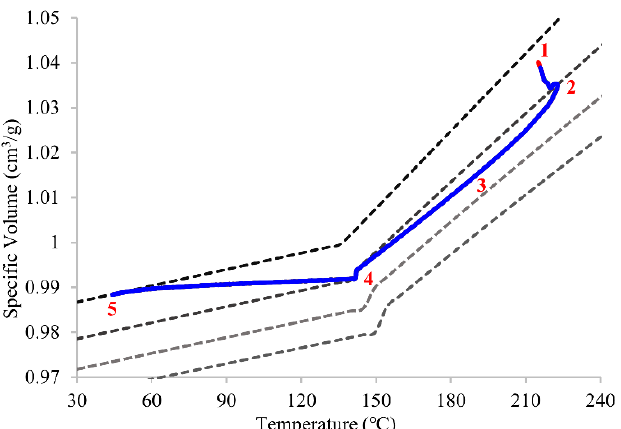
Figure 6. The practical PVT processing path for the whole injection molding process is